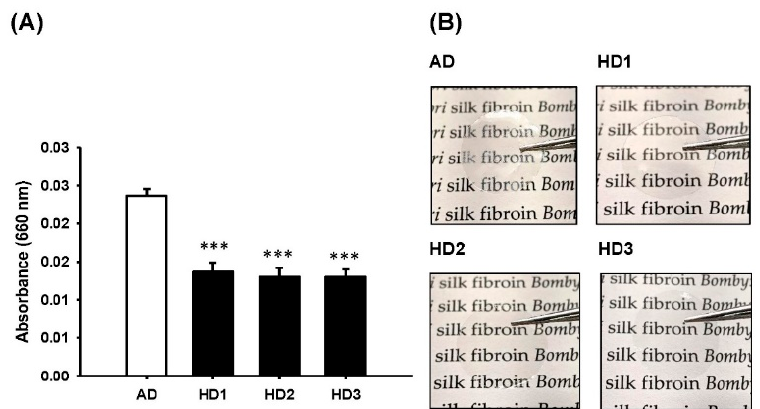
Figure 2. Effects of different degumming procedures on transparency of silk fibroin preparations. ( A ) Absorbance at 660 nm of the SF solution derived from alkaline degumming (AD) and heat degumming for 1, 2, and 3 h (HD1–3) procedures. ( B ) Comparison of the bright-field images of silk fibroin films. Statistically significant differences between AD and HD were determined by Dunnett’s multiple comparison post hoc test. *** p < 0.001; n = 4; all error bars represent the standard error of the